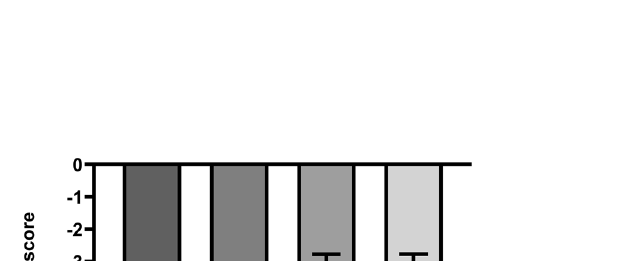
Figure 4. Planned contrasts for change in depressive symptoms ( M , SE ; DASS-21) from pre- to post- intervention for all groups (contrast 1: all OLPs vs. natural history; contrast 2: OLP nasal spray (passive + active) vs. capsule; contrast 3: active OLP vs. passive OLP (nasal spray, capsule)).